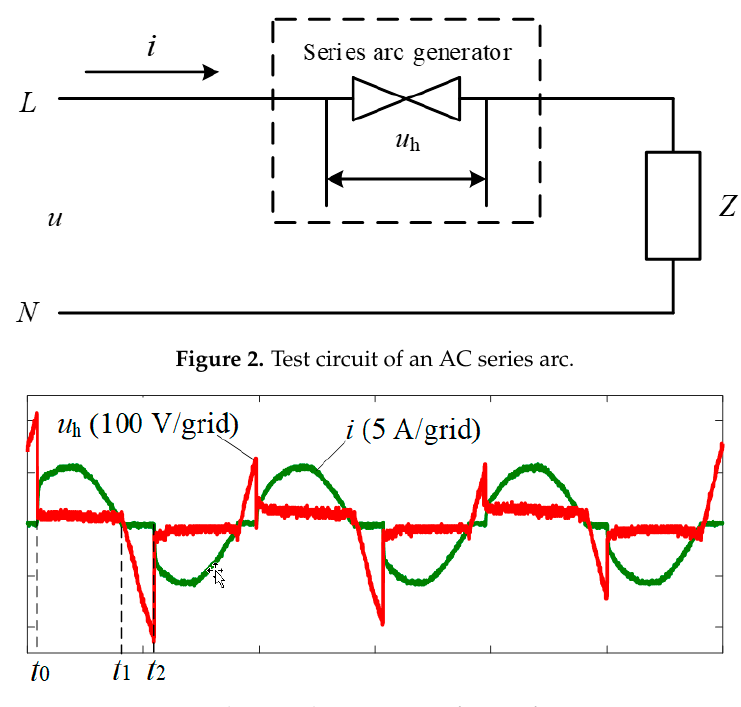
Figure 3. Voltage and current waveforms of an AC arc.